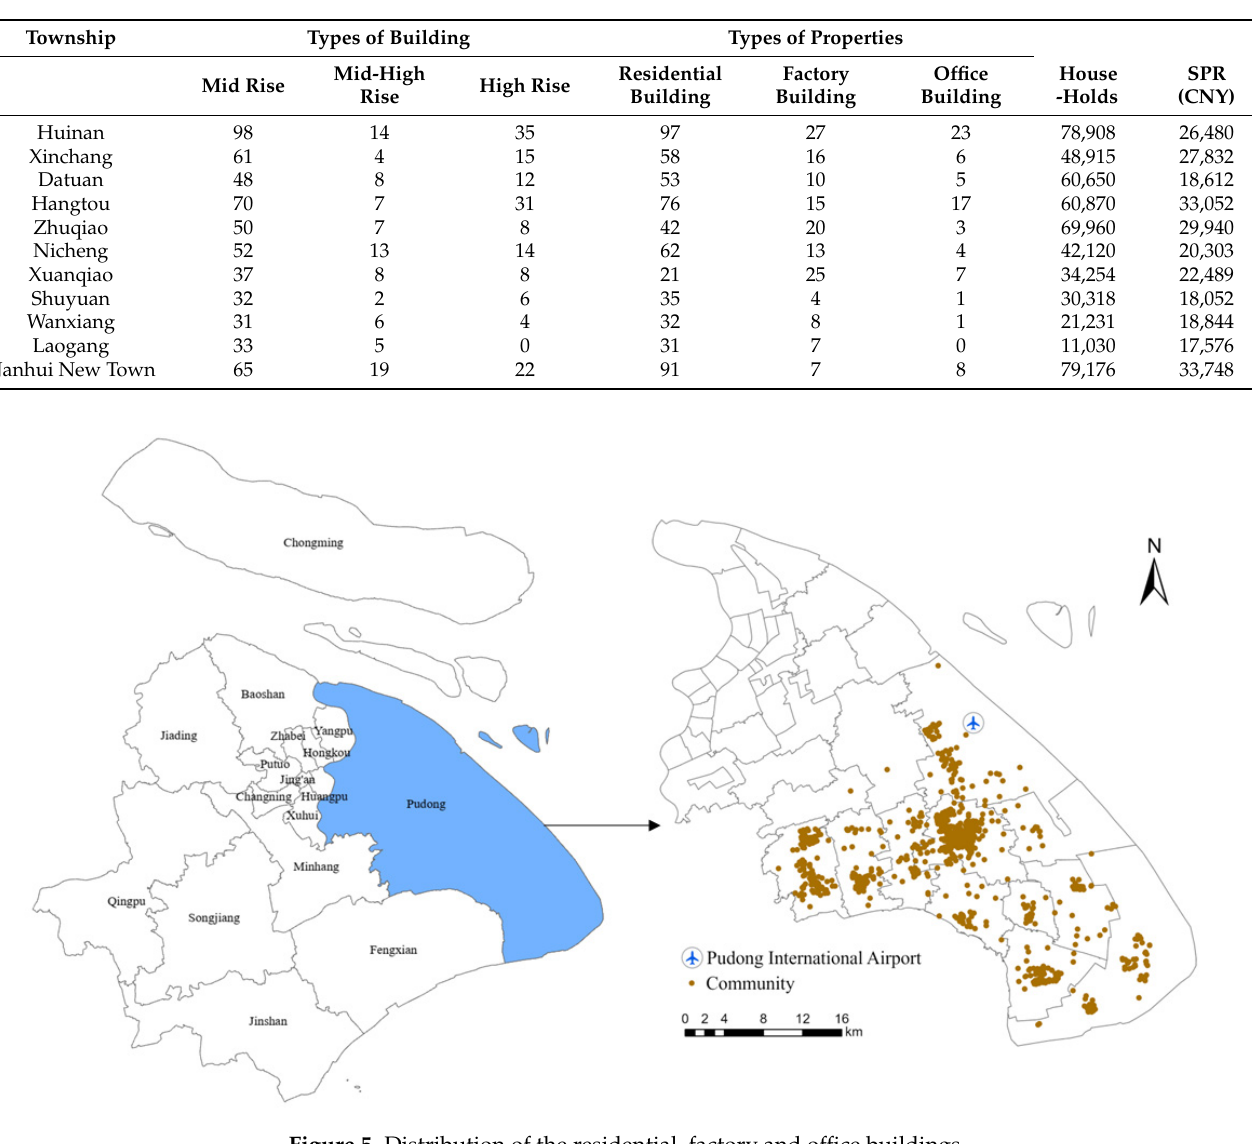
Figure 5. Distribution of the residential, factory and office buildings.